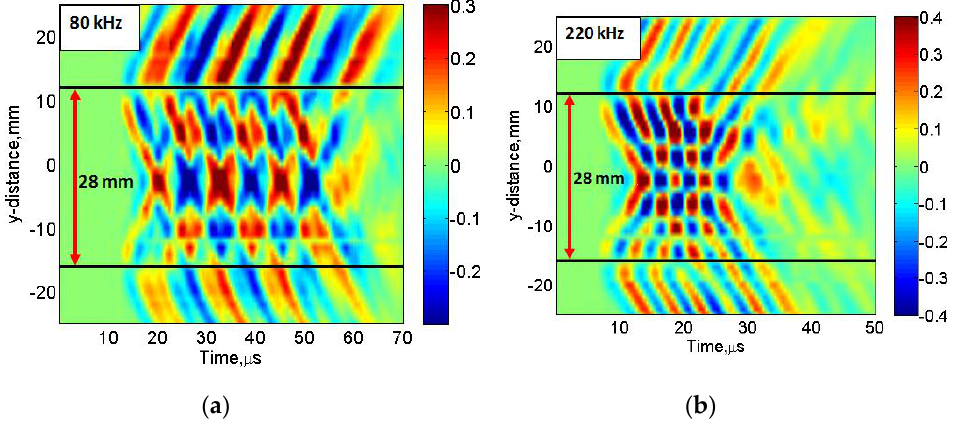
Figure 7. B-scan along the longitudinal axis of MFC transducer at 80 kHz ( a ) and at 220 kHz ( b ).